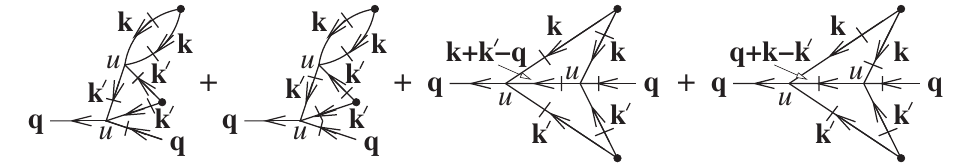
FIG. 5. Two-loop one-particle-irreducible Feynman diagrams contributing to the propagator self-energy or two-point vertex function Γ q ; ω Þ . The two graphs on the right induce nonclassical values for the exponents η , z , η ~ ψψ (cid:2) ð